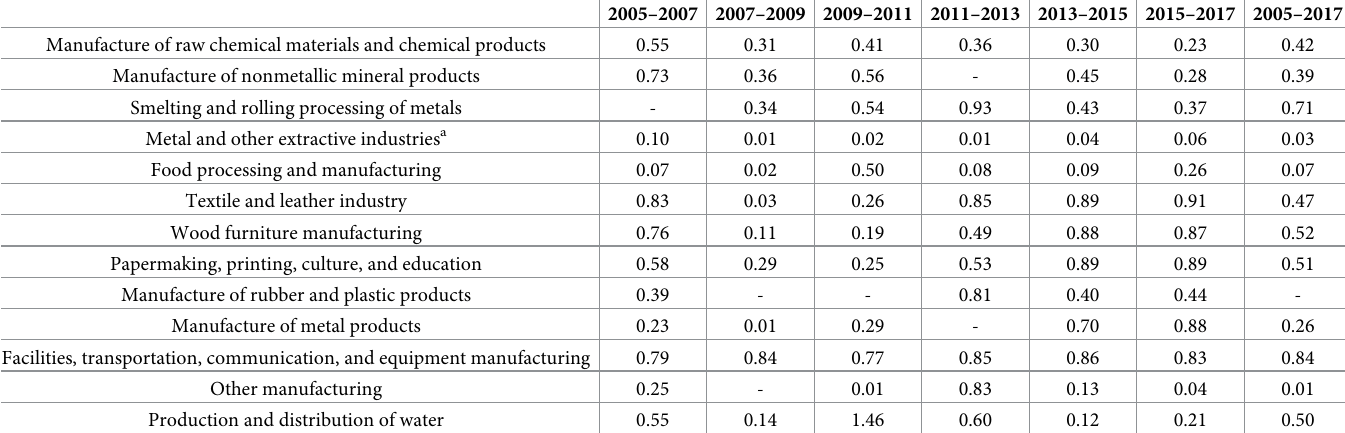
Table 6. Energy rebound effects of subsectors within the energy-consuming industry during